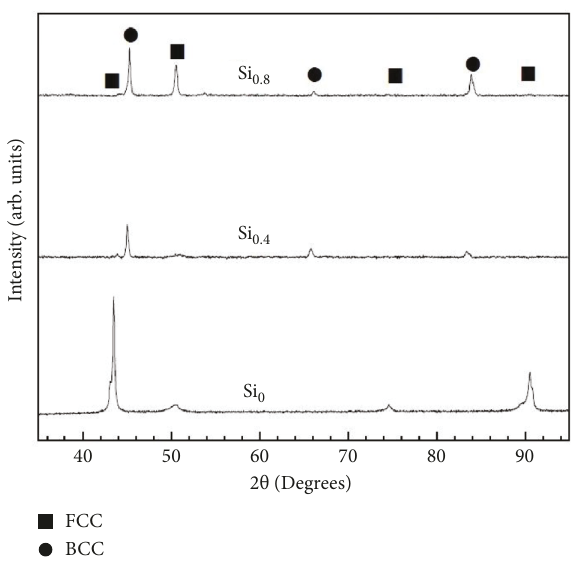
0.5 CoCrCuFeNiSi x (as-cast) [30].